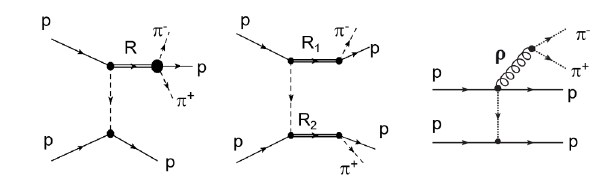
Figure 5. Diagrams of the three processes taken into account in the simulation of the pp → pp π + π − reaction. Left: Excitation of one positively charged resonance followed by decay into p π + π − . Center: Excitation of one doubled charged and one neutral res- onance followed by their decay into p π − and p π + respectively. Right: direct ρ meson